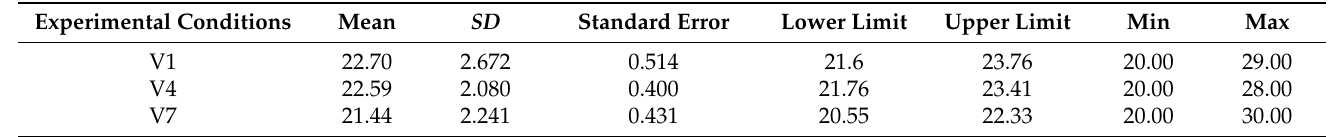
Table 4. Descriptive values of clicks made in the pairing cards experiment.